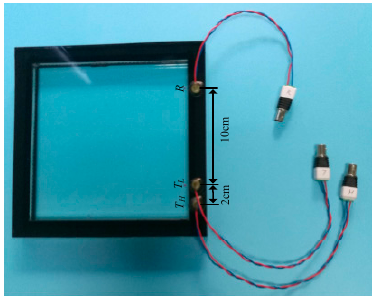
Figure 5. Hidden frame supported glass curtain wall with PZTs.